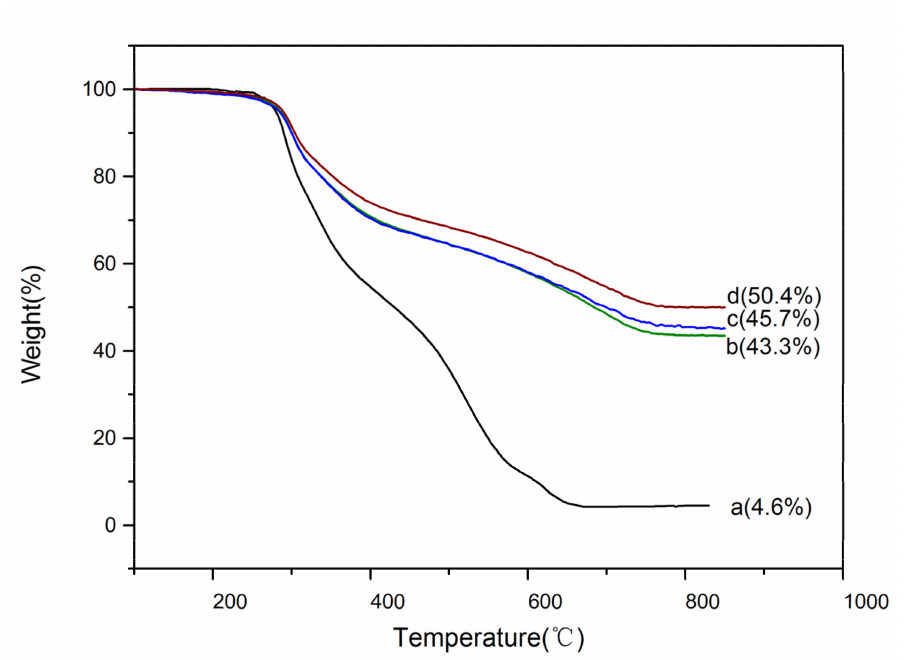
Figure 6. TGA curves of ( a ) SF fiber templates, ( b–d ) the SF@silica NFs corresponding TEOS additions from 3, 5 to 7 mL, respectively.